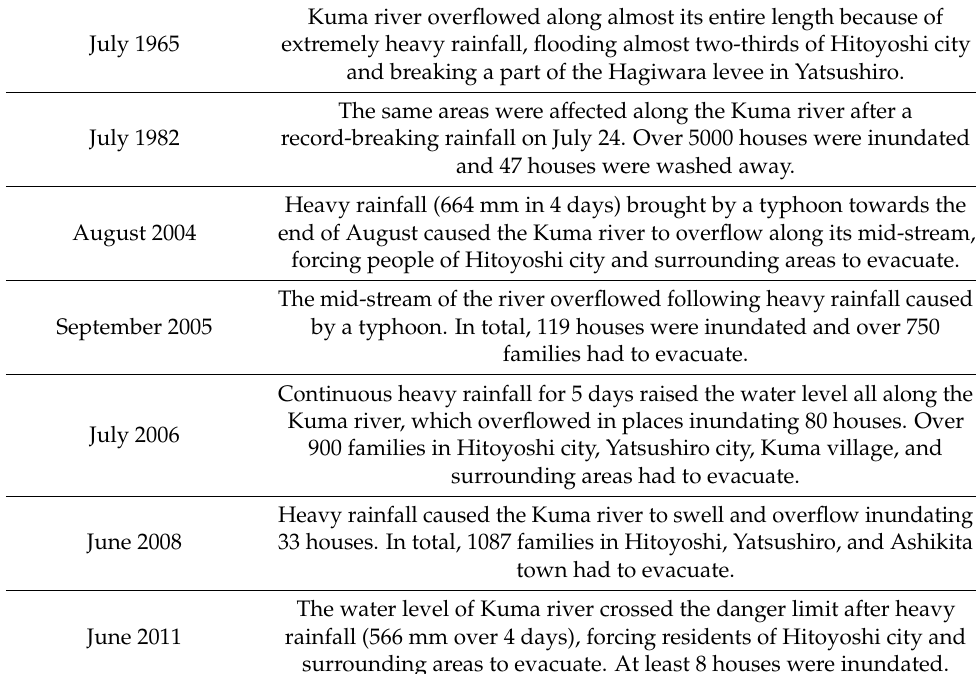
Table 1. Major floods along the Kuma River since the